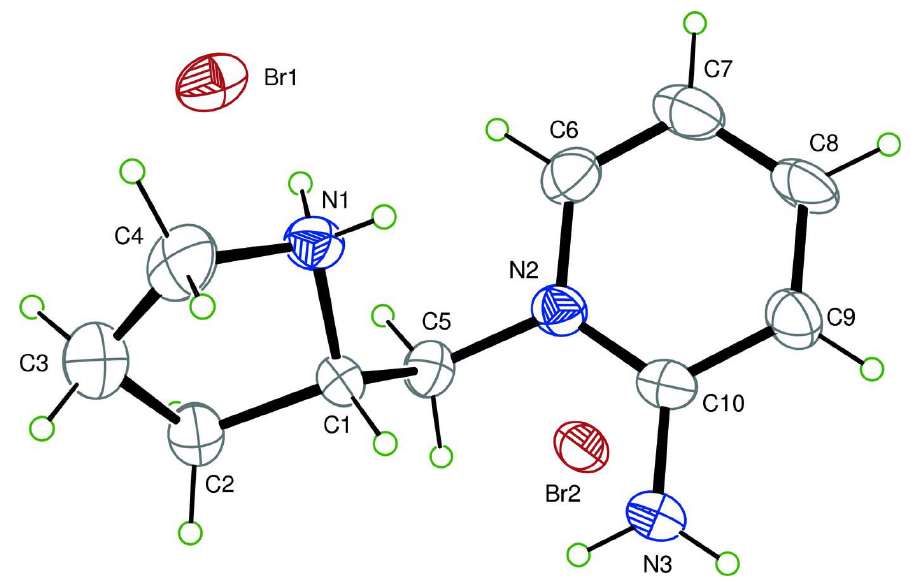
The asymmetric unit of the crystal structure of the title compound with the atomic labeling scheme. Displacement ellipsoids are drawn at the 40% probability